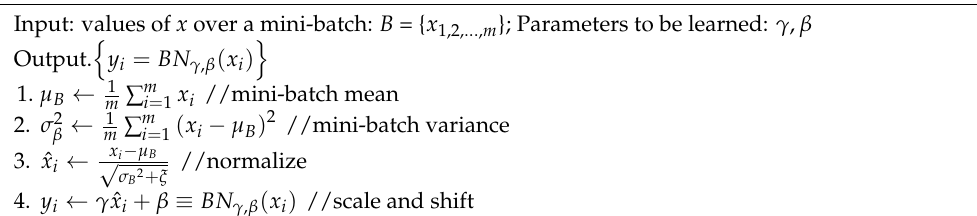
Algorithm 1 Batch Normalizing